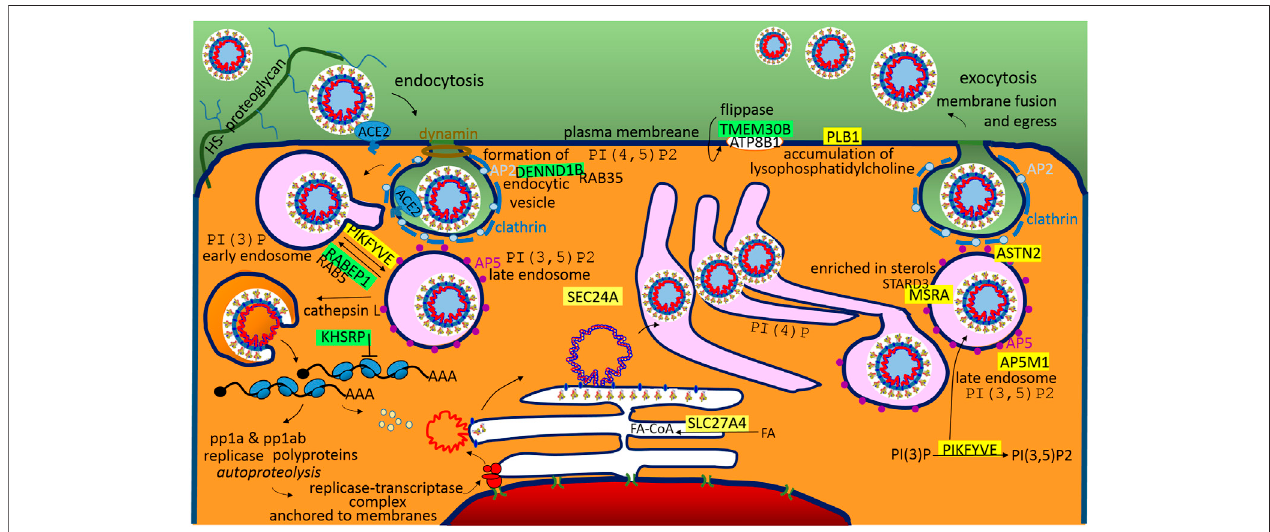
FIGURE 4 | A graphical illustration of “ SARS-CoV-2 life cycle in the host cells. ” Green highlights show the alignments with the complement sequence (post- transcriptionally repressed); yellow highlights show the alignments with the reverse complement sequence (post-transcriptionally promoted). The functions of the identi fi ed genes/proteins by the methodology are summarized in Supplementary Table S1